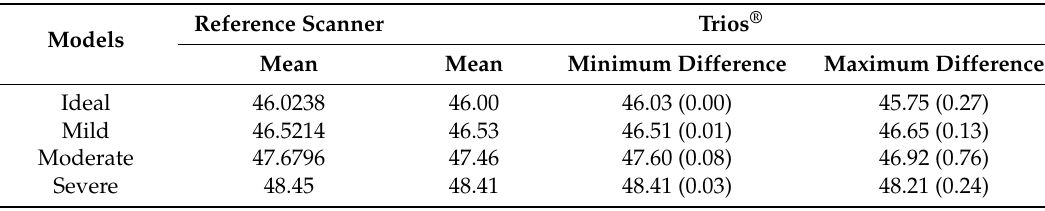
Table 4. Comparison of differences in intermolar widths between Trios ® and the reference scanner (unit: mm).